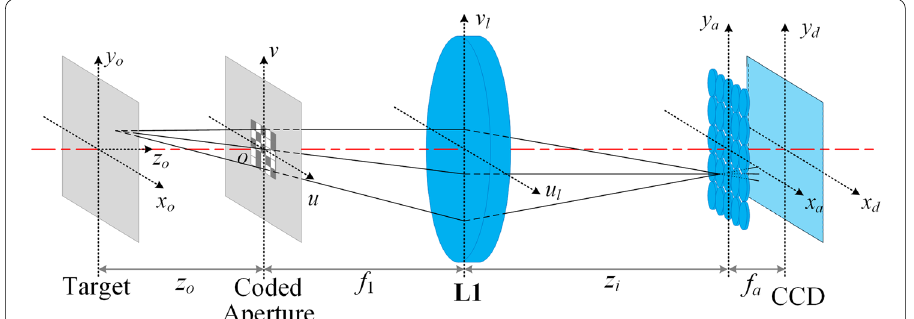
Fig. 4 The layout of CLFIS without dispersion in